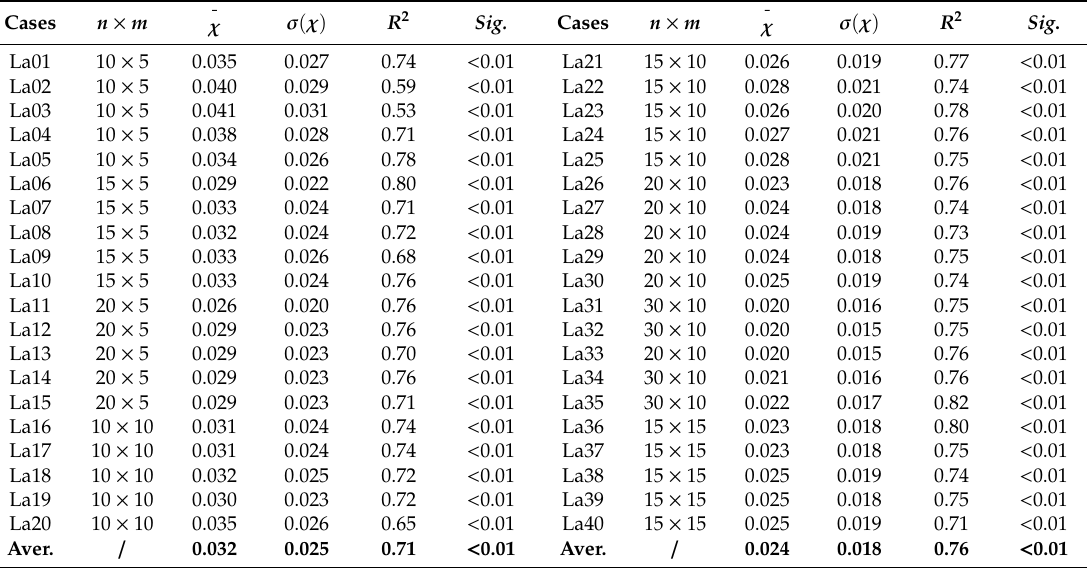
Table 1. The experimental results of the meta-model in the problem set LA.